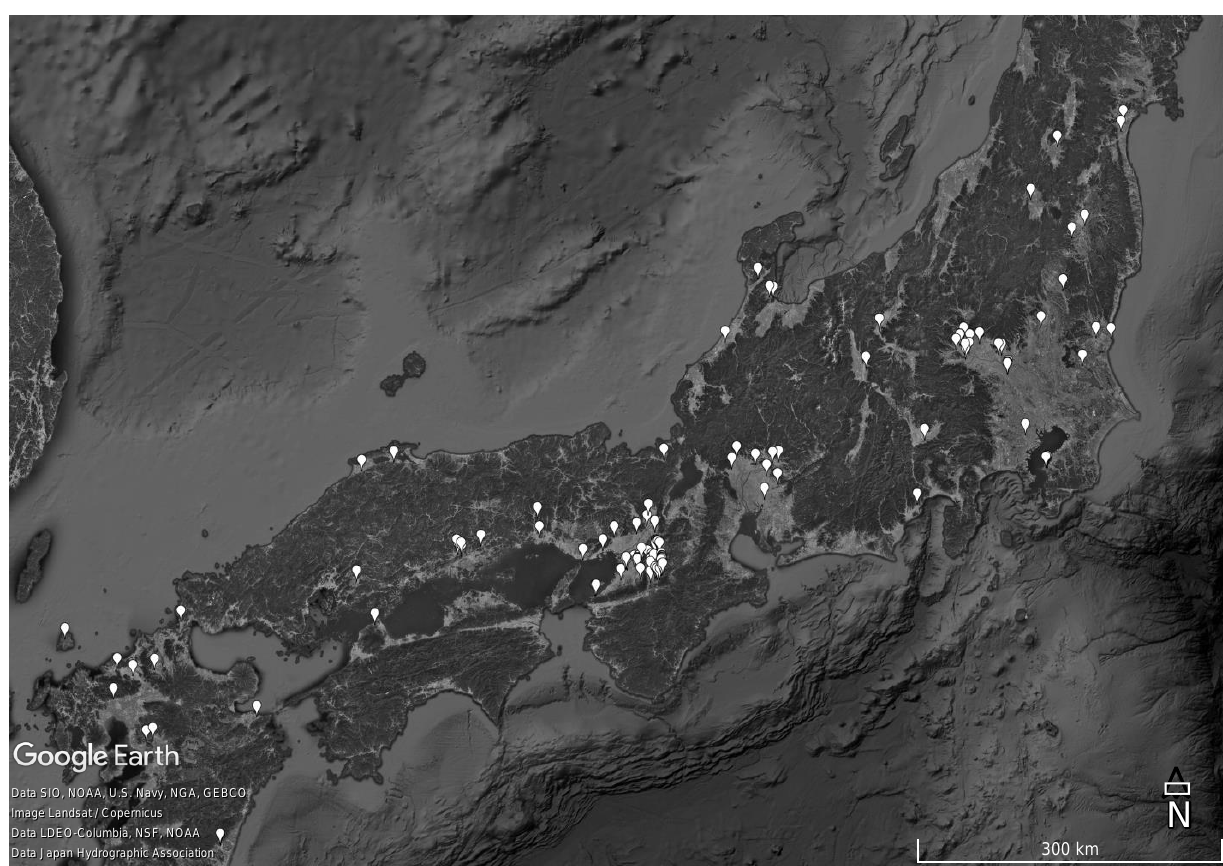
Figure 1. Locations of the sites considered in this study (image courtesy Google Earth Pro, edited by the authors).